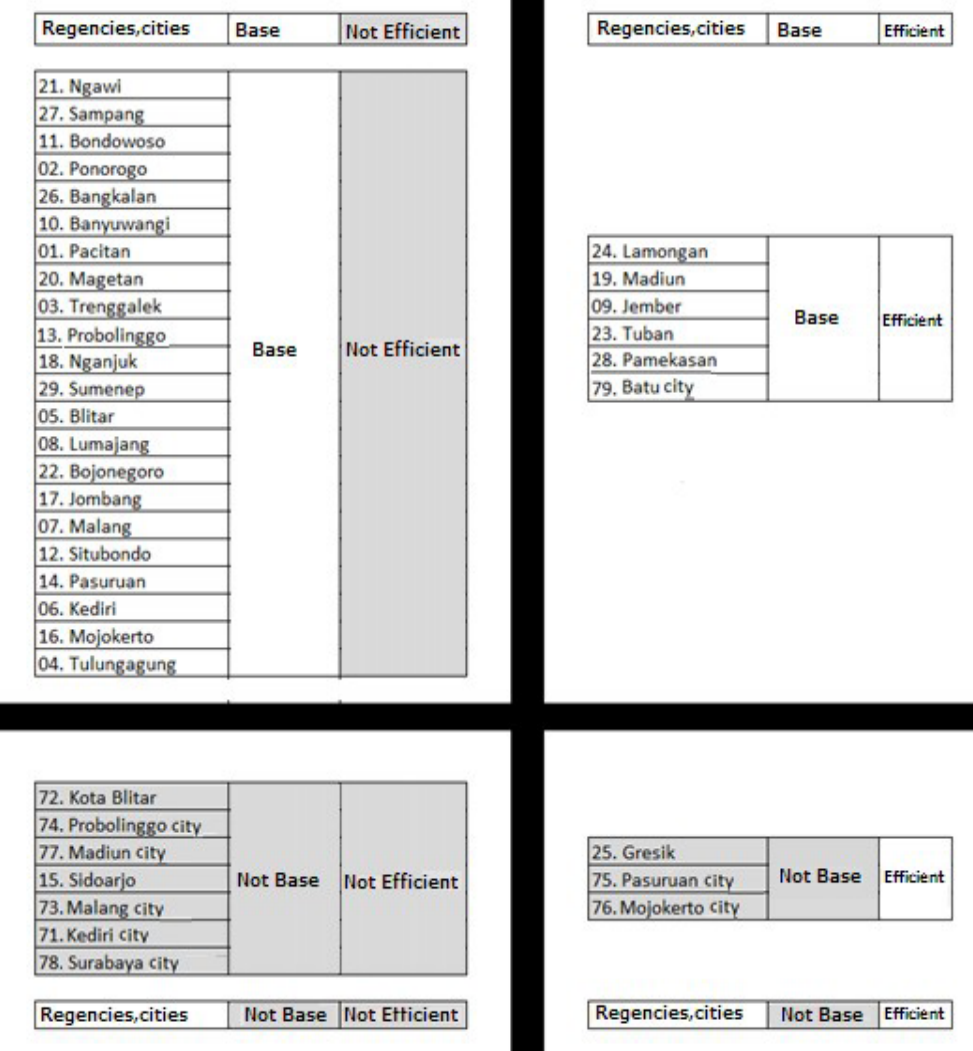
Figure 4: Topology Base and TheEfficiency of Rice